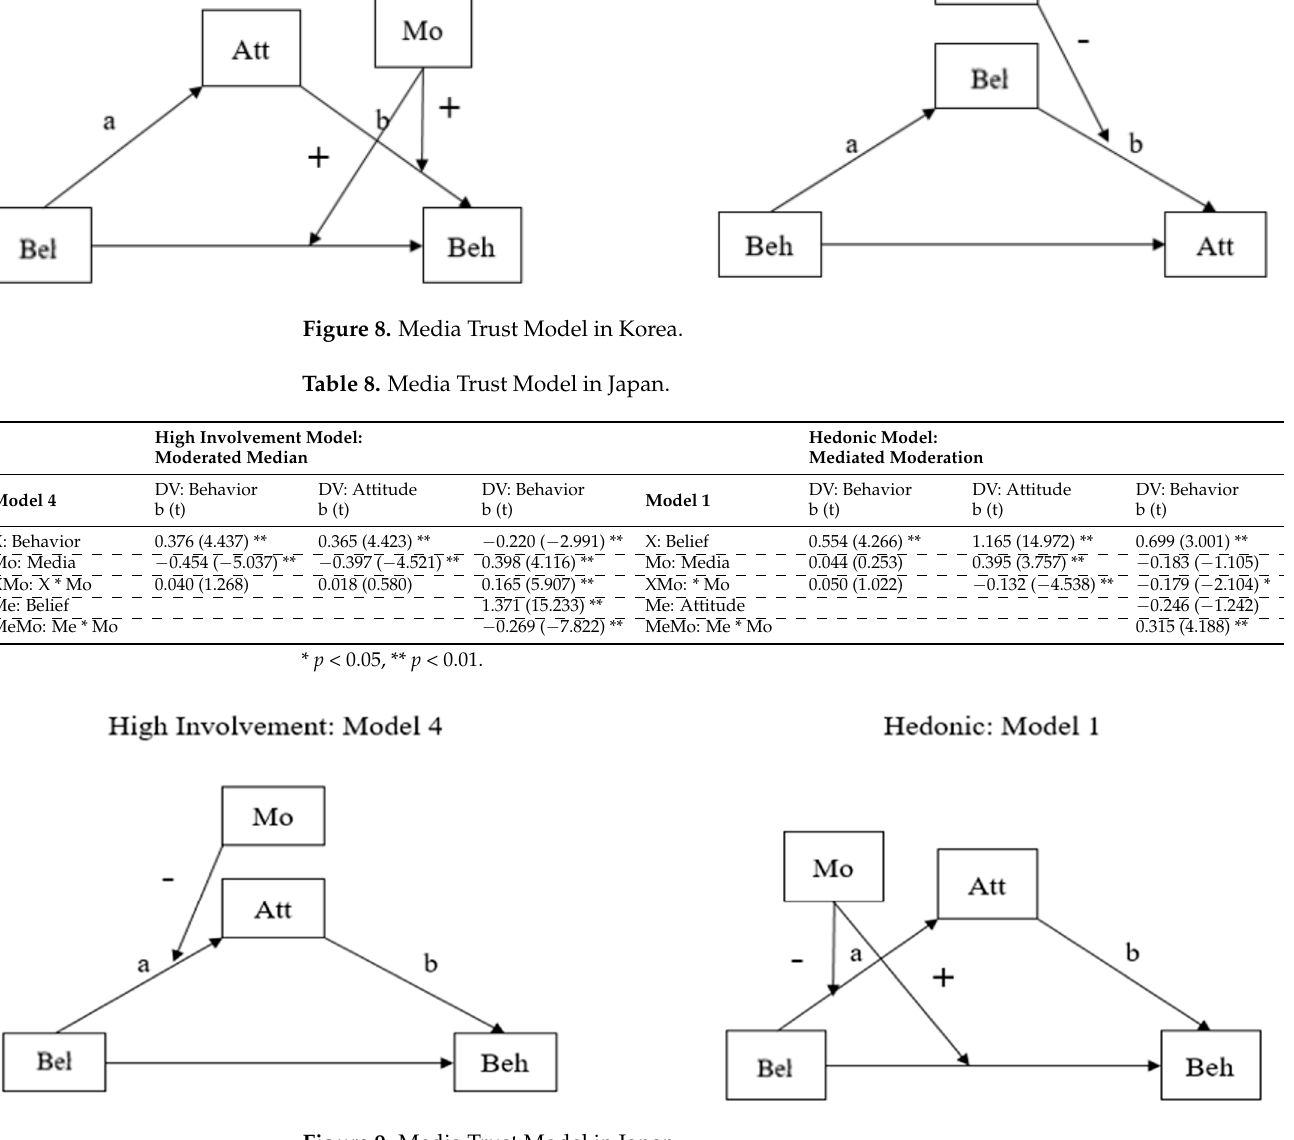
Figure 9. Media Trust Model in Japan. Viewing from moderation and mediation effect, in the case of high involvement, a mediated moderation model (Model 2) was detected. In the hedonic case, a moderated mediation model (Model 5) was found in Korea. In Japan, similar to Korea, two cases of high-involvement and hedonic cases were detected. However, the details are somewhat different. Per high involvement, Japanese citizens used a moderated mediation model (Model 4), and, in the hedonic case, they followed a mediated moderation model (Model 1). By using the same verifying model as the one used for the effect of trust in the government, the regression results show us which patterns fit into the models. Both Korean and Japanese citizens used only two models: high-involvement and hedonic models. In general, trust in the media has an effect on citizens’ beliefs and